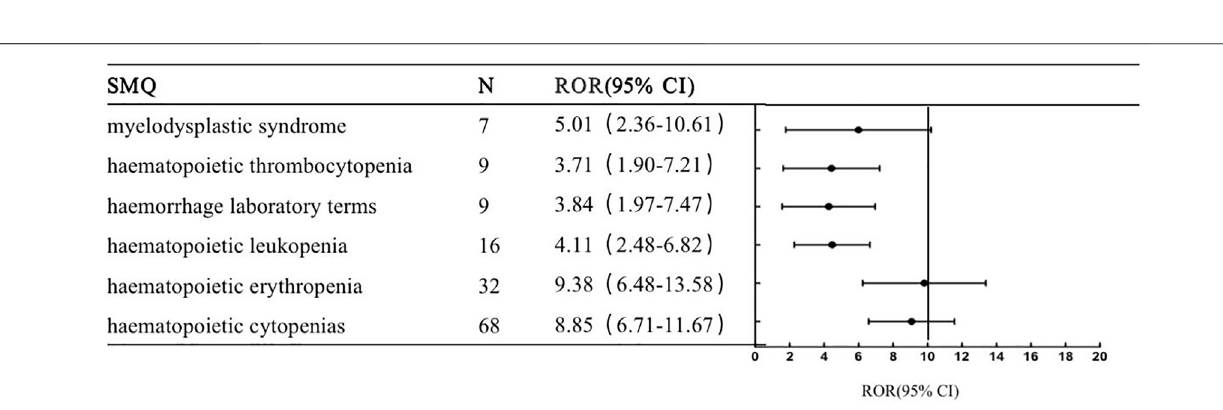
Frontiers in Pharmacology |